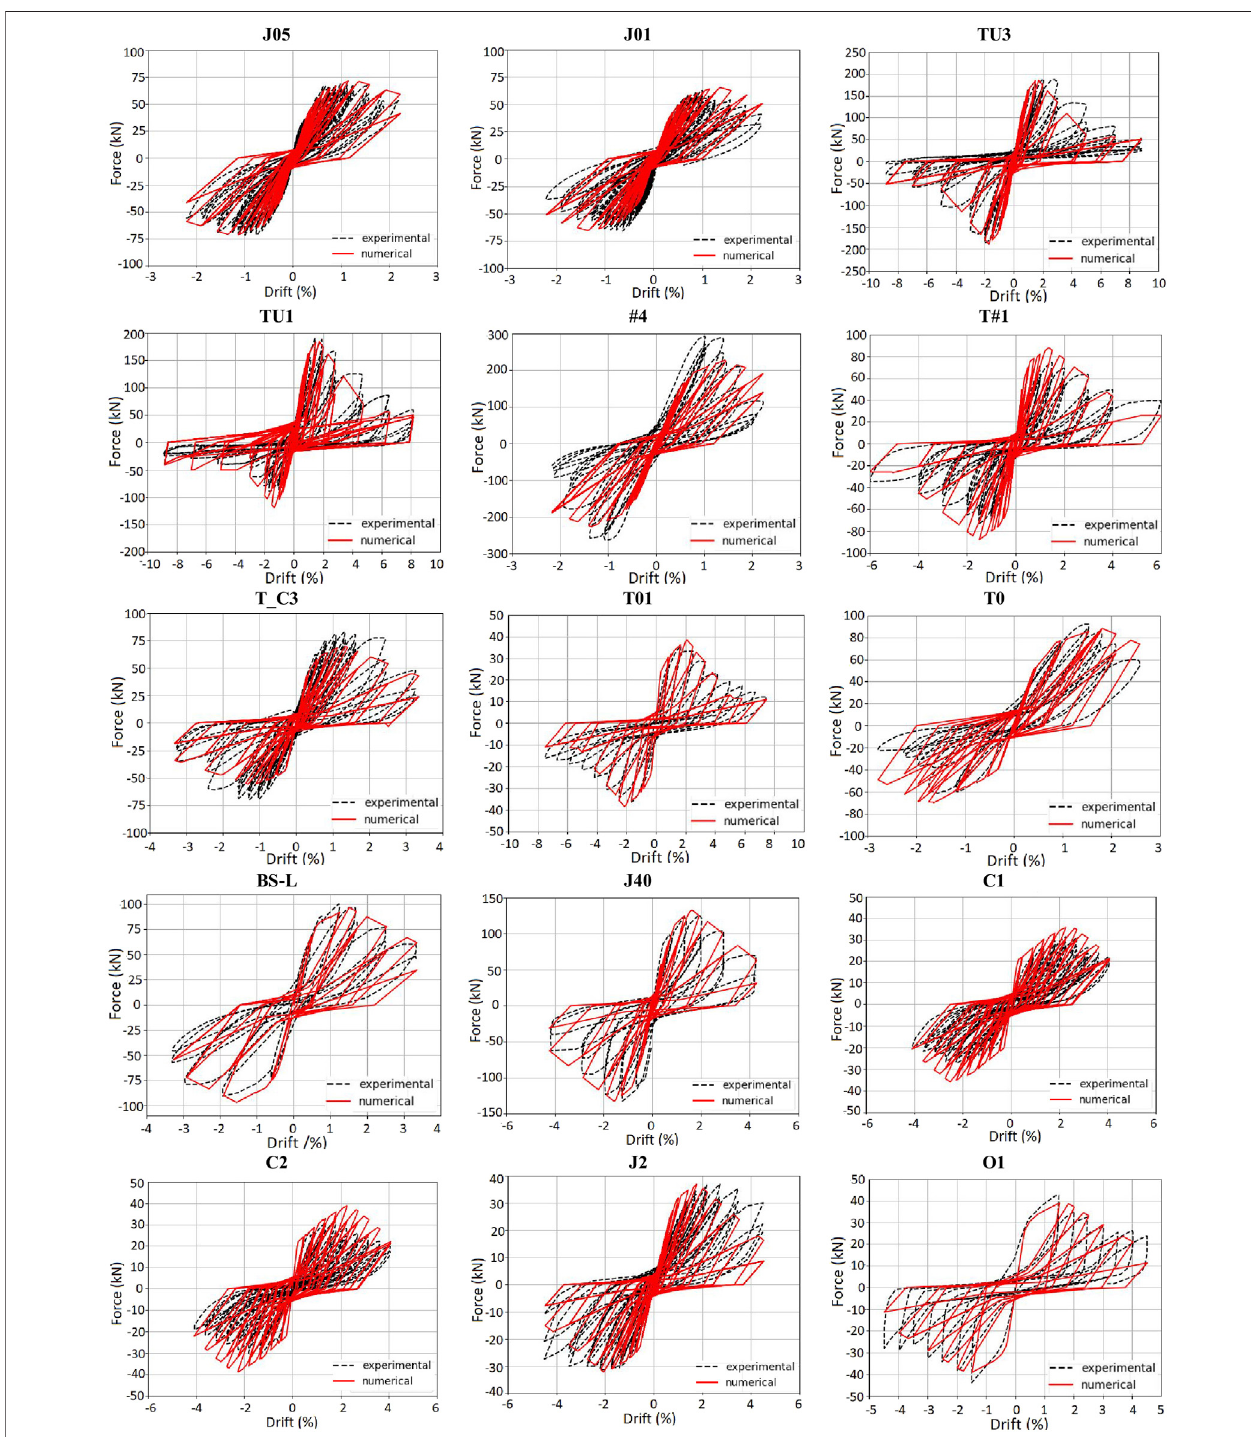
FIGURE 13 | Force – drift cyclic response using the pinching parameters proposed by Jeon (Mitra and Lowes, 2007).